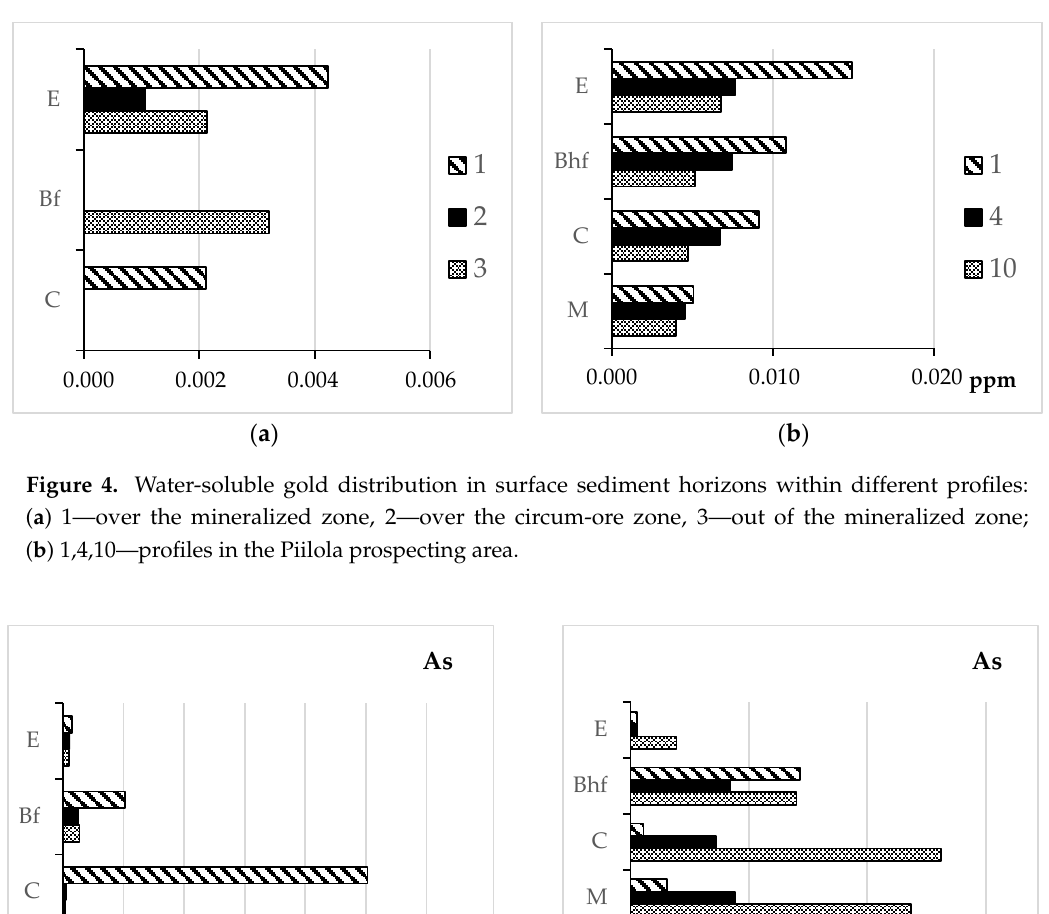
Figure 3. The changes of gold’s mobile form concentration in the studied soil horizons within different profiles: ( a ) 1—over the mineralized zone, 2—over the circum-ore zone, 3—out of the mineralized zone; ( b ) 1,4,10—profiles in the Piilola prospecting area.